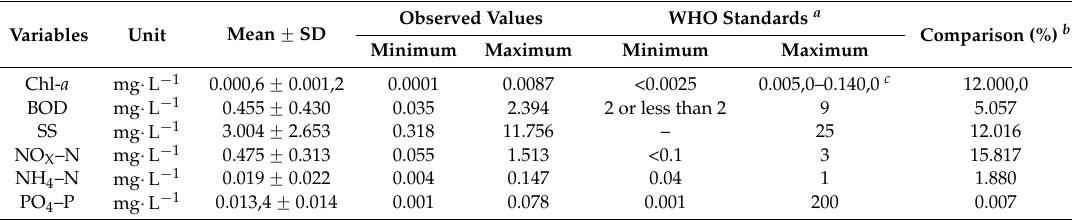
Table 3. Summary of water quality indicators measured at sampling sites ( n = 57) compared with WHO standards. (Minimum value of suspended solid is not recorded in WHO standards). For Chl- a , the number of significant digits is four for precise